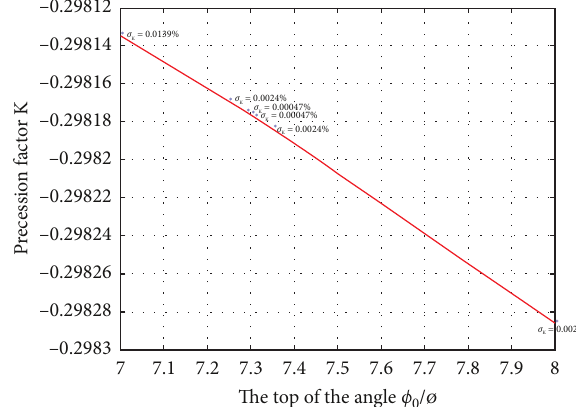
� 7 . 3 o ). F and K ( φ 0